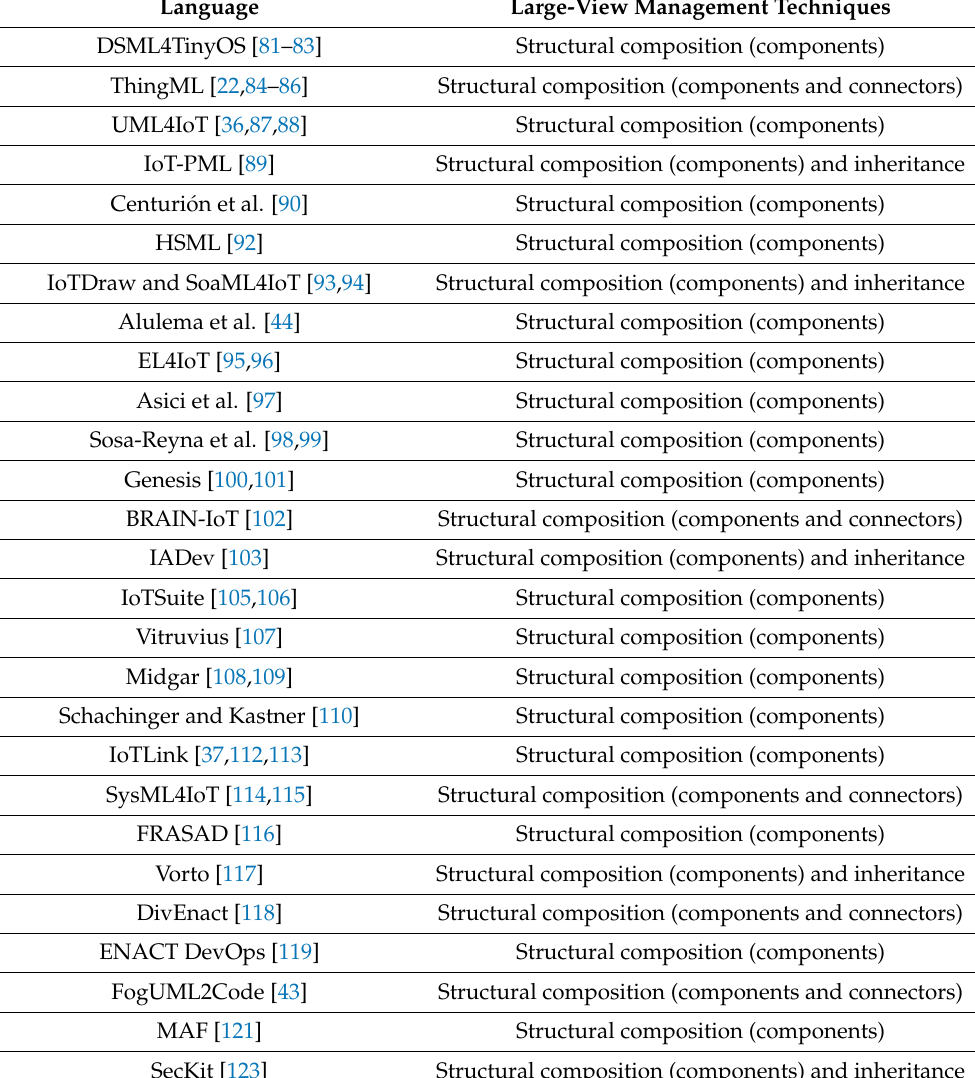
Table 8. The modeling languages for IoT that support large-view management.